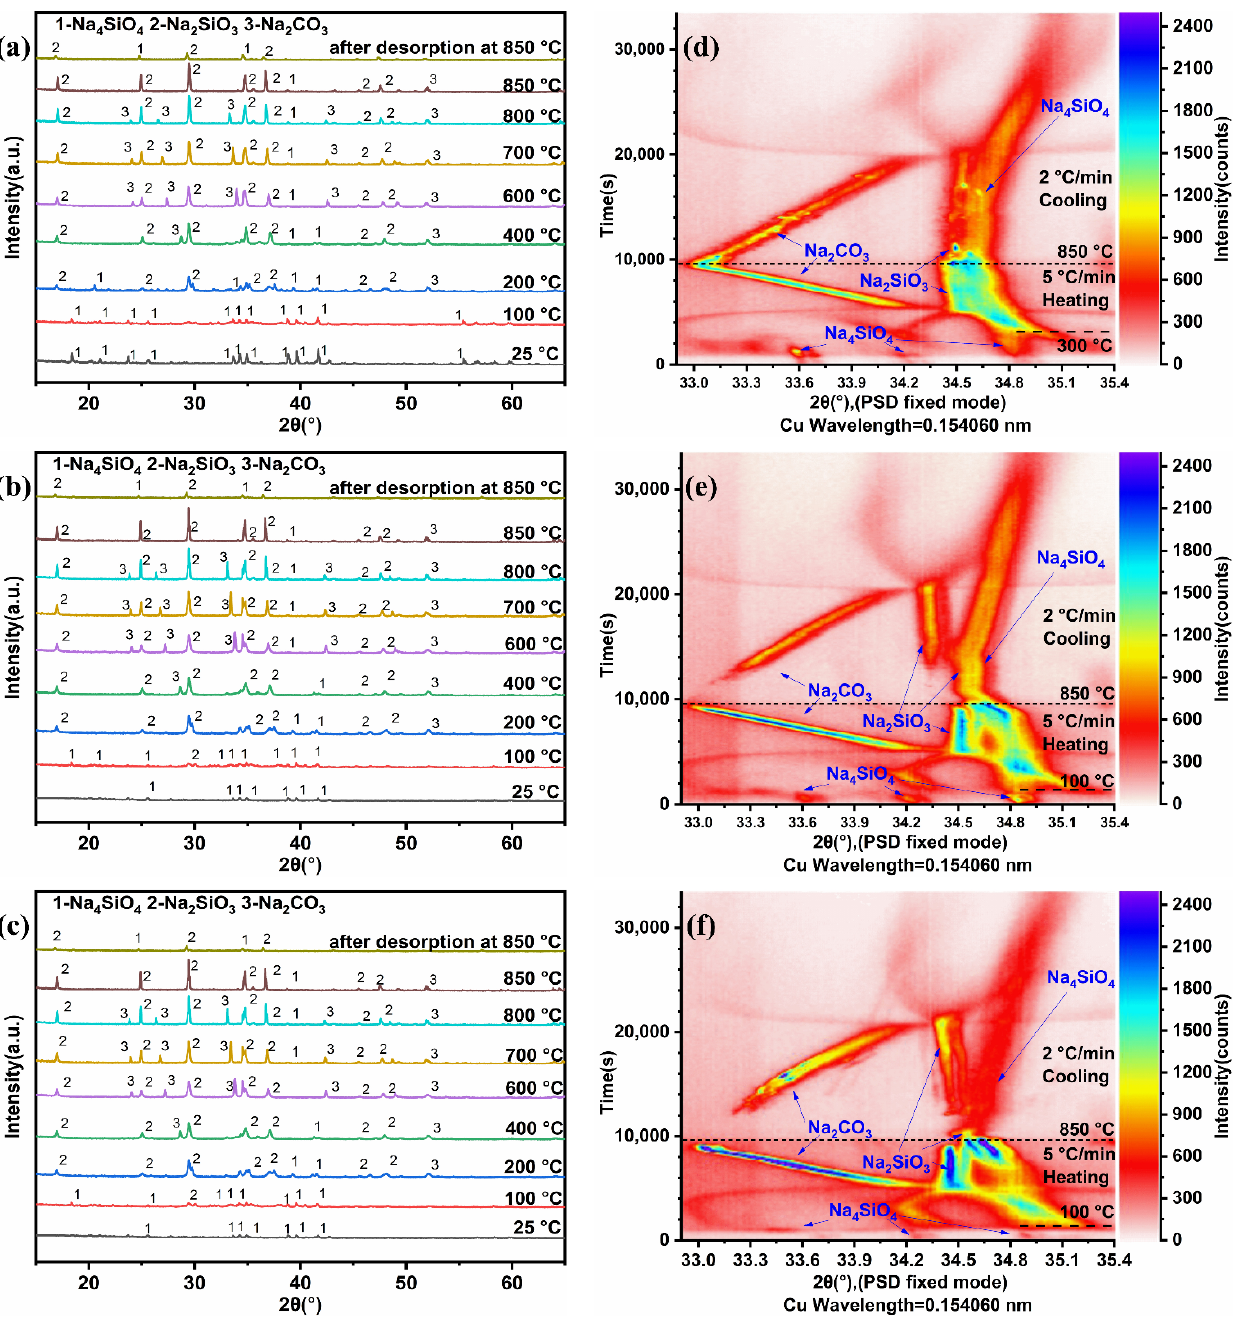
Figure 2. In situ XRD patterns of ( a,d )P–Na, ( b,e )10(LiNa)90Na, and ( c,f )10(LiNaK)90Na at 25–850 °C in the 80 vol% CO 2 –20% N 2 atmosphere; ( a – c ) in full ‐ pattern scanning model over the range of 15–65° and ( d – f ) in the PSD model over the range of 32.8–35.4°. To investigate the phase evolution of alkali carbonate-doped Na 4 SiO 4 during CO 2 uptake, 10(LiNa)90Na and 10(LiNaK)90Na were used as representatives and characterized in the same temperature regime and atmosphere as described above, and their XRD plots